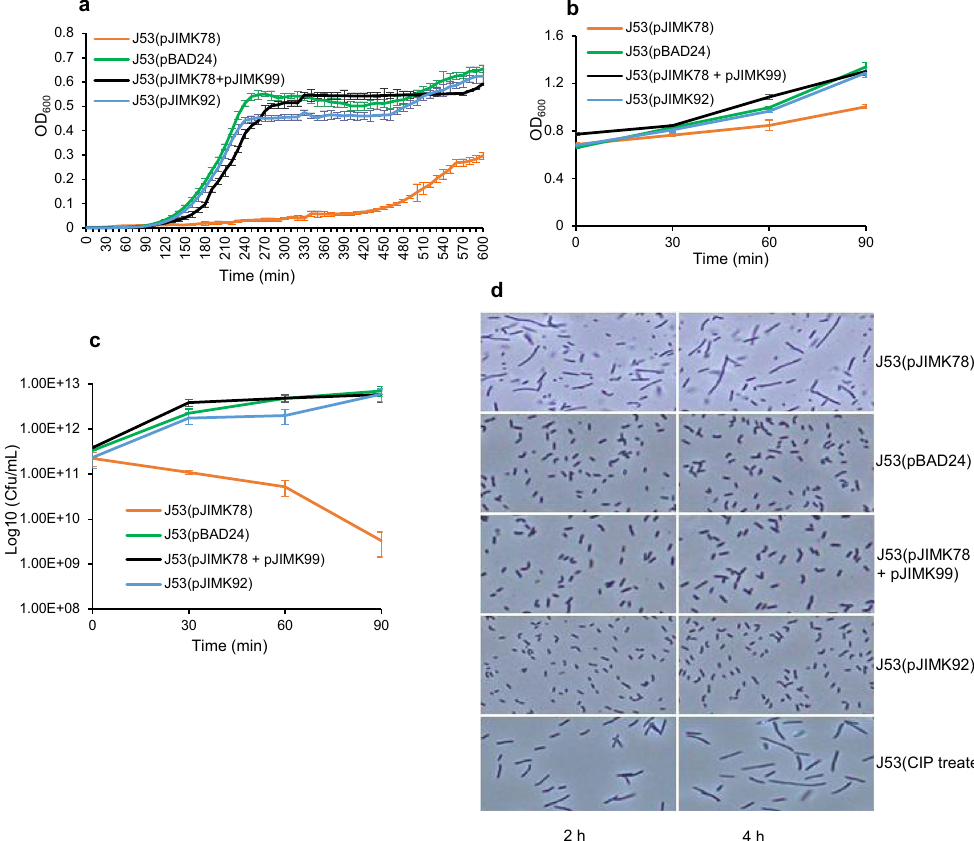
Figure 3. Effects of ParE I toxin on E. coli growth, survival and cell morphology. J53(pJIMK78) growth is significantly inhibited compared to J53(pBAD24) empty vector, J53(pJIMK92) expressing the truncated ParE I toxin and J53(pJIMK78 + pJIMK99) expressing both toxin and antitoxin, respectively, with ParE I continually expressed from beginning of culture ( a ). Optical density ( b ) and viable bacterial count ( c ) were also reduced after toxin induction in mid-logarithmic phase. ( d ) Elongated cell morphology in J53(pJIMK78) with ParE I toxin expressed (top panel) is similar to CIP-treated (0.25 µ g/mL) J53 cells (bottom panel), while normal cell morphology is observed in the presence of the truncated toxin (2nd panel from bottom) or empty vector (2nd panel from top) or with the co-expression of toxin and antitoxin (3rd panel from top). Each experiment was repeated three times, and the mean values with standard deviations (error bars) are